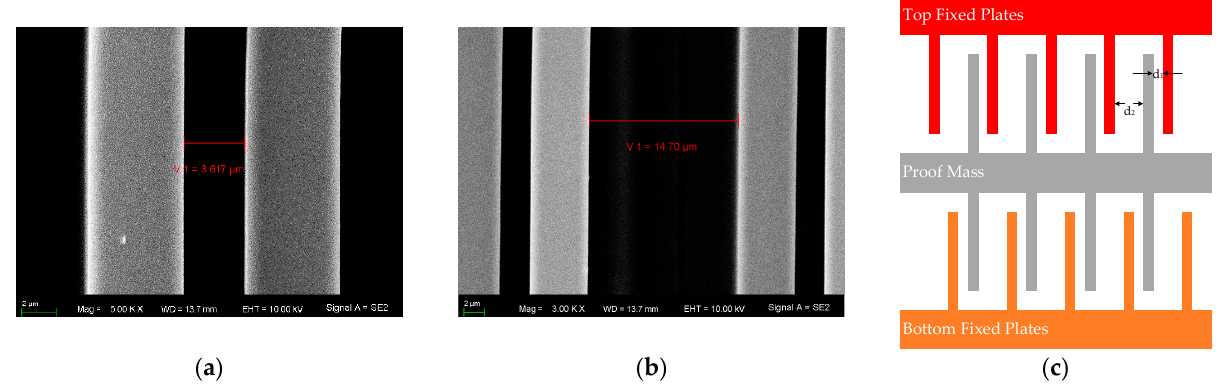
Figure 9. Experimental measurement of gap: ( a ) confocal laser scanning microscope; ( b ) measurement results; ( c ) capacitance model.